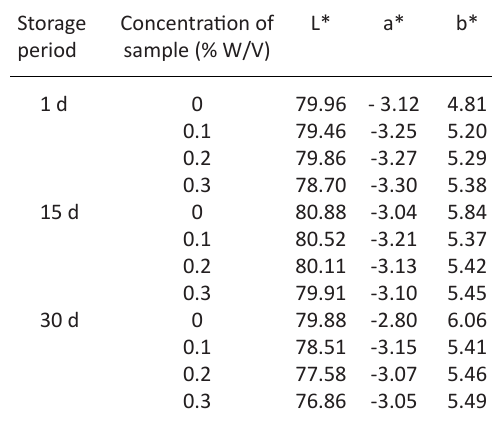
Table 4. Changes in color of pasteurized milk with chitosan nanoparticals (CNP) at different concentrations (0.1, 0.2 and 0.3% w/v) and without CNP during (1, 15 and 30) days of storage at 5°C